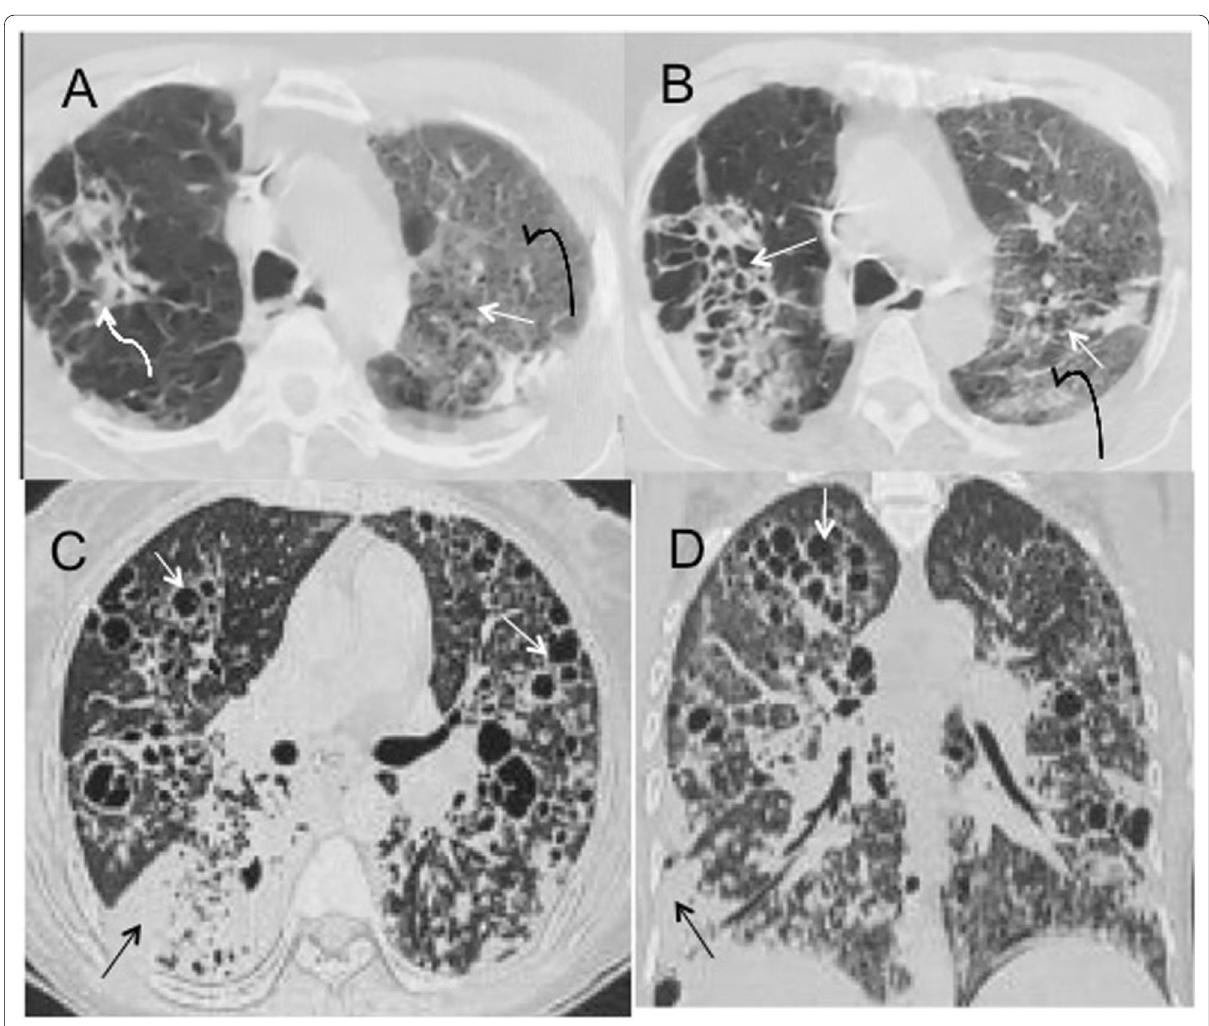
Fig. 5 Cystic changes as post-COVID sequelae. a Reticular changes in right upper lobe (curved white arrows) with GGO in left upper lobe (curved black arrow) with interspersed microcystic changes (white arrow), b honeycombing like cystic changes with adjacent reticulations (white arrow) with GGO in left upper lobe (curved black arrow), c , d axial and coronal image of a patient showing extensive bilateral cystic lung disease (white arrows) with consolidation in right lower lobe (black arrow) due to superimposed